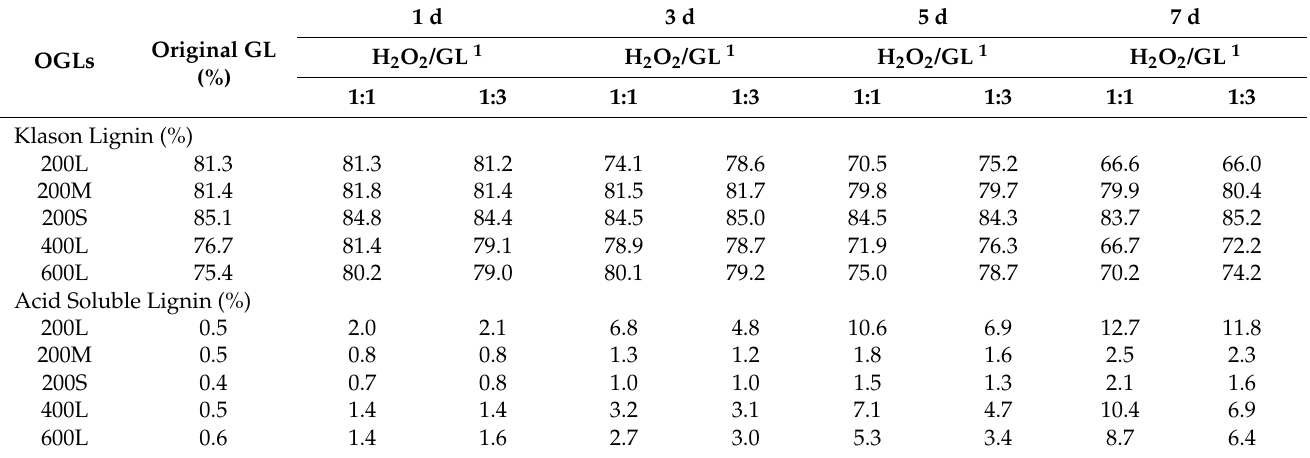
Table 2. Klason lignin and acid soluble-lignin content of